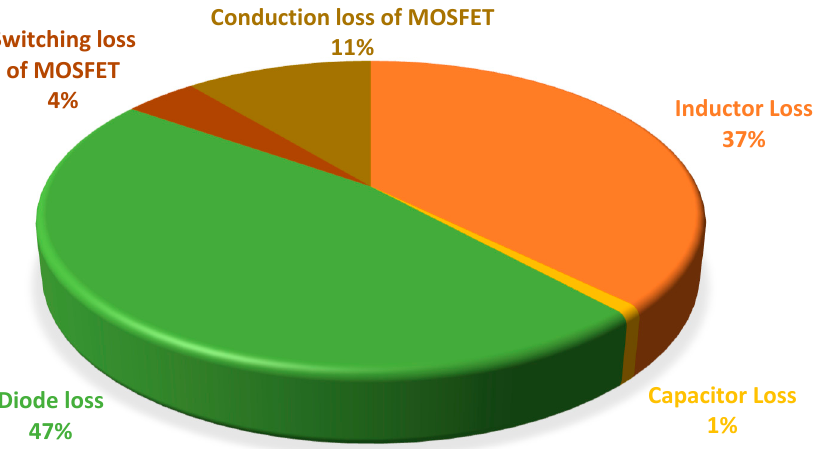
Figure 10. Converter loss breakdown chart for HG-SIQBC topology .